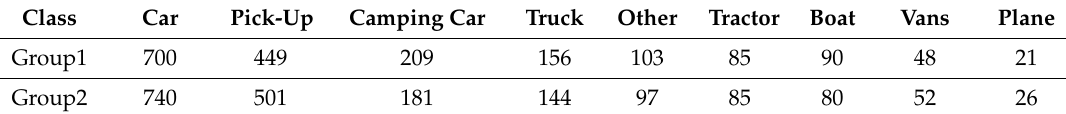
Table 2. Vehicle number statistics in training dataset of VEDAI.